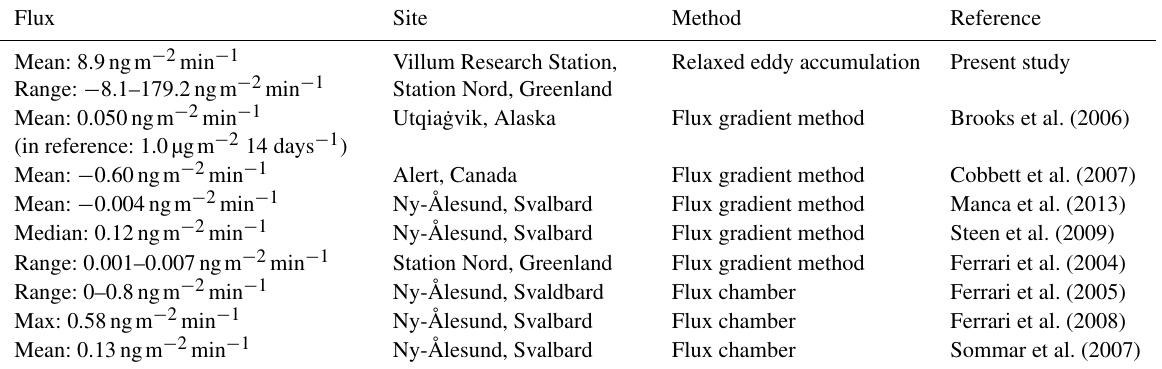
Table 1. Summary table over reported GEM fluxes in the Arctic. The units are changed from those within the references for better comparison.